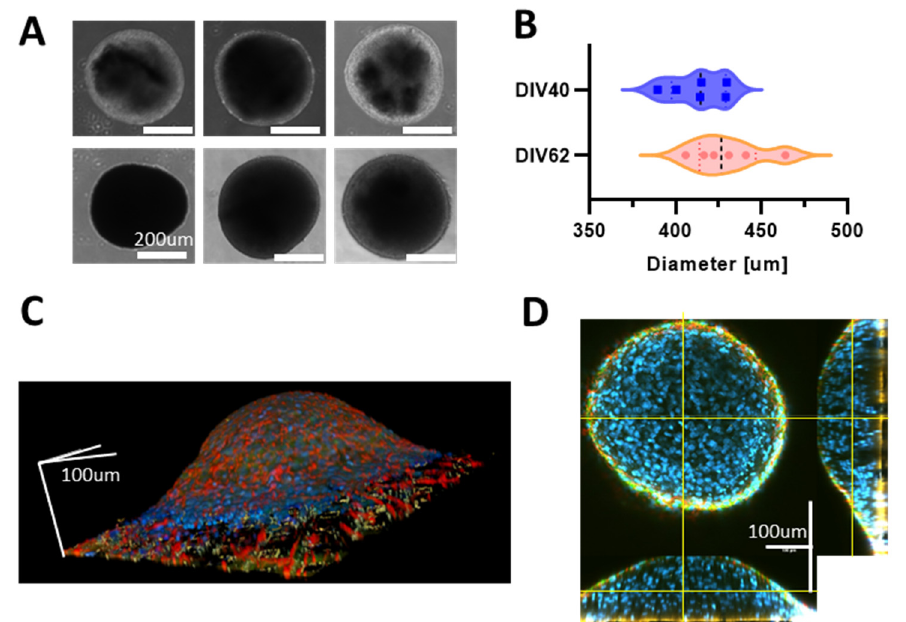
Figure 2. ( A ) Images of different neurospheroids in the free culture during development. The first row shows pictures obtained at DIV 40 and second row at DIV 62. Scale bar, 200 µ m. ( B ) Evaluation of the mean diameter of n = 6 neurospheroids at DIV 40 and DIV 62 in the free culture. ( C ) Reconstruction of the 3D volume of a neurospheroid plated on a HD-MEAs at DIV 35 and fixed at DIV 62. Images were acquired with a confocal microscope using a z-stack of scale bars that represent 100 µ m in each direction. ( D ) Orthogonal view of the sample shown in ( B ). Yellow lines represent the observation plane. In blue: DAPI, green: MAP2, red: GFAP. Scale bars represent 100 µm in each direction.